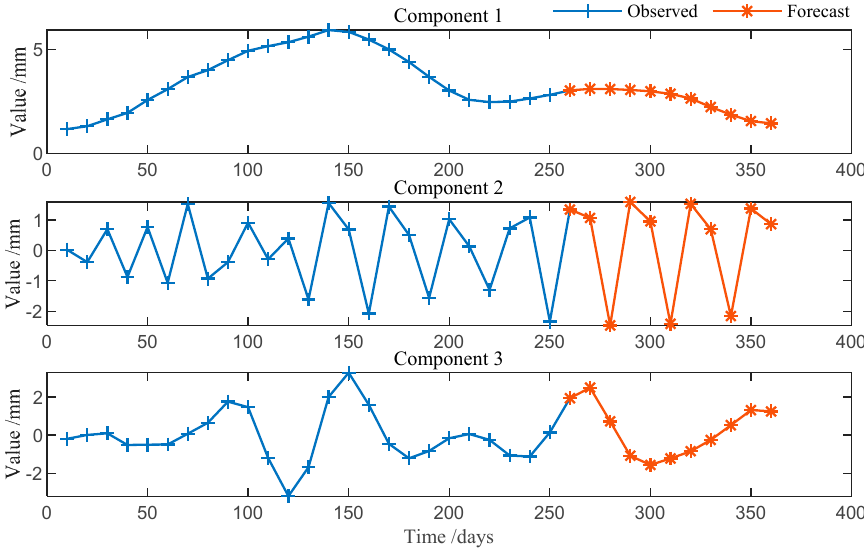
Figure 8. Forecast results of displacement subsequences using SLSTM networks.